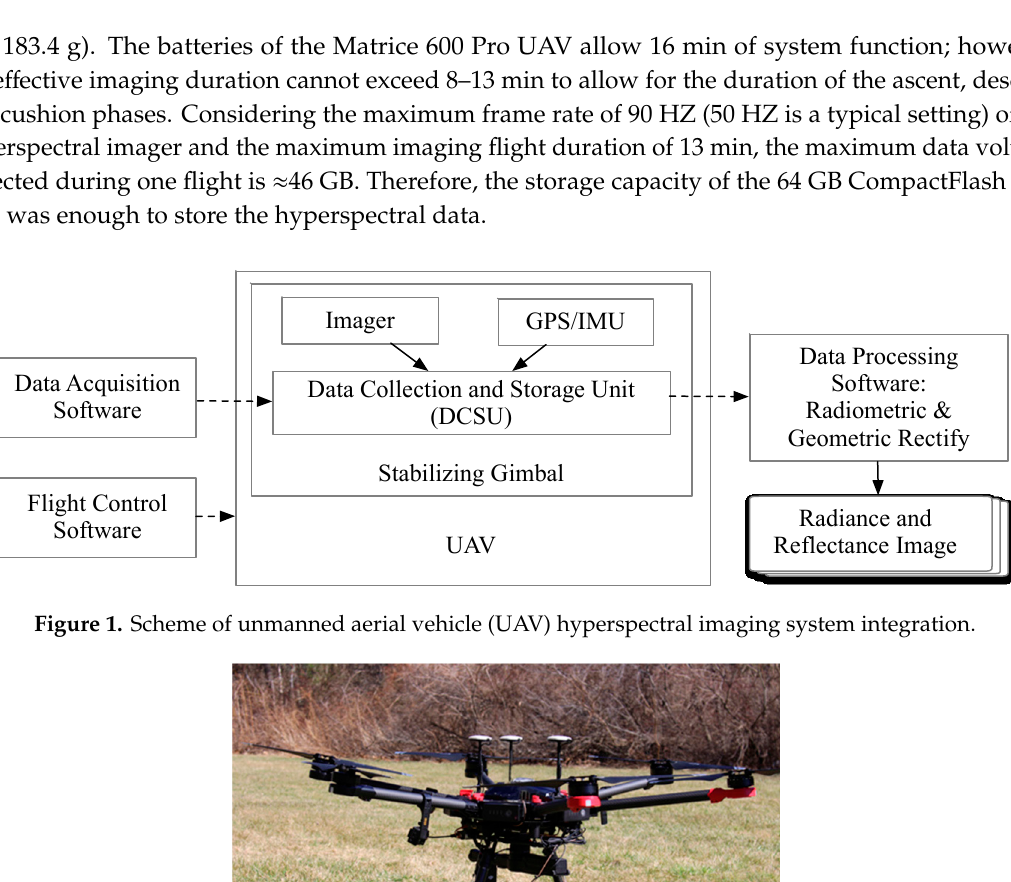
Figure 3. ( a ) Schematic and ( b ) photograph of data collection and storage unit (DCSU).